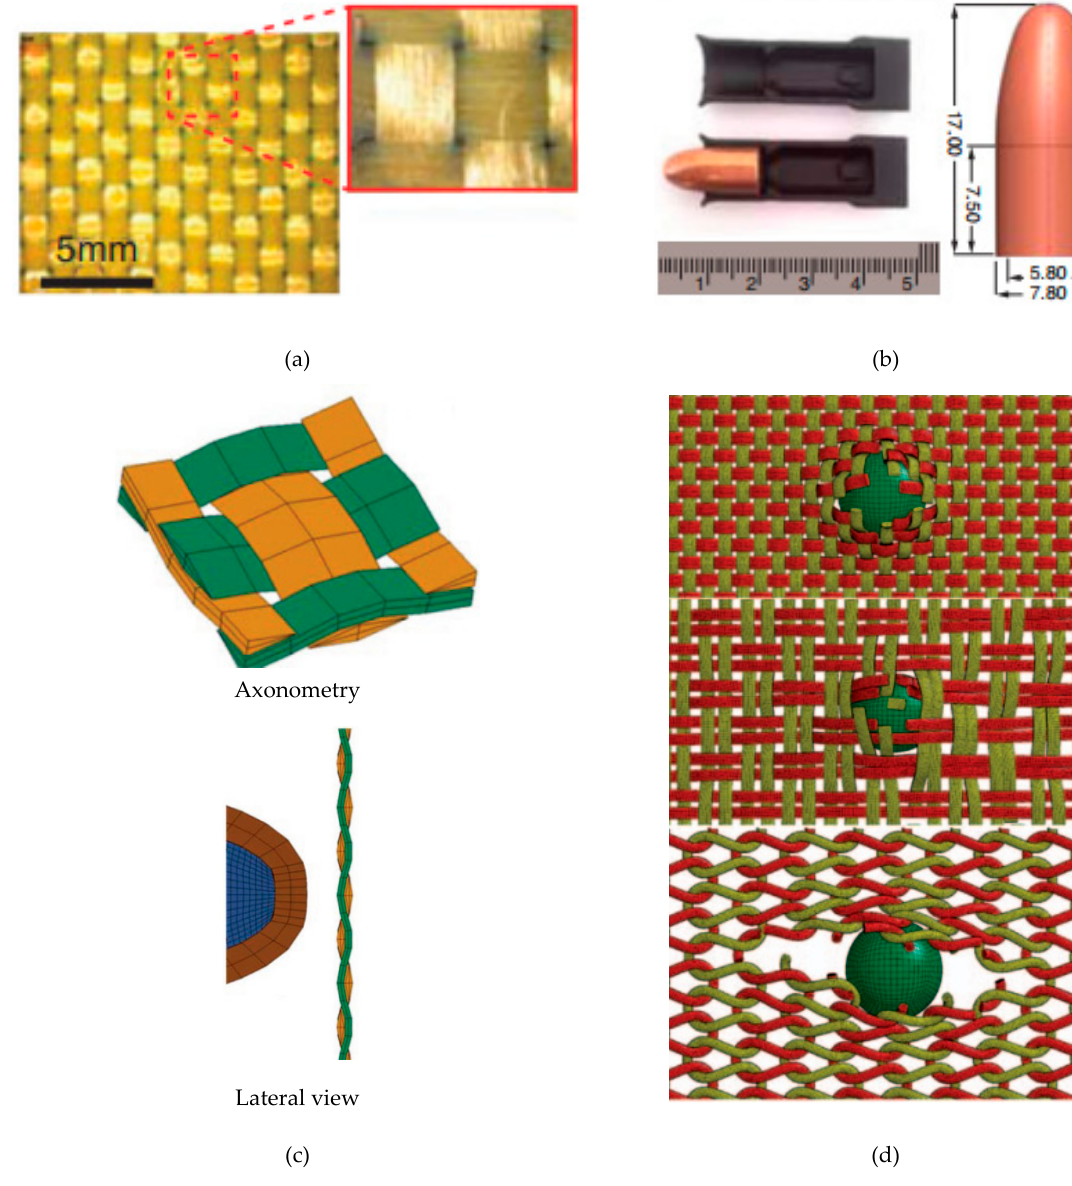
Figure 15. Refined finite element numerical modelling of textile curtains under ballistic impact, for the protection of glass facades (reproduced from [90]): ( a ) fabric detail; ( b ) bullet sabot (with nominal dimensions in mm); ( c ) detail of the typical numerical model and ( d ) predicted failure patterns.